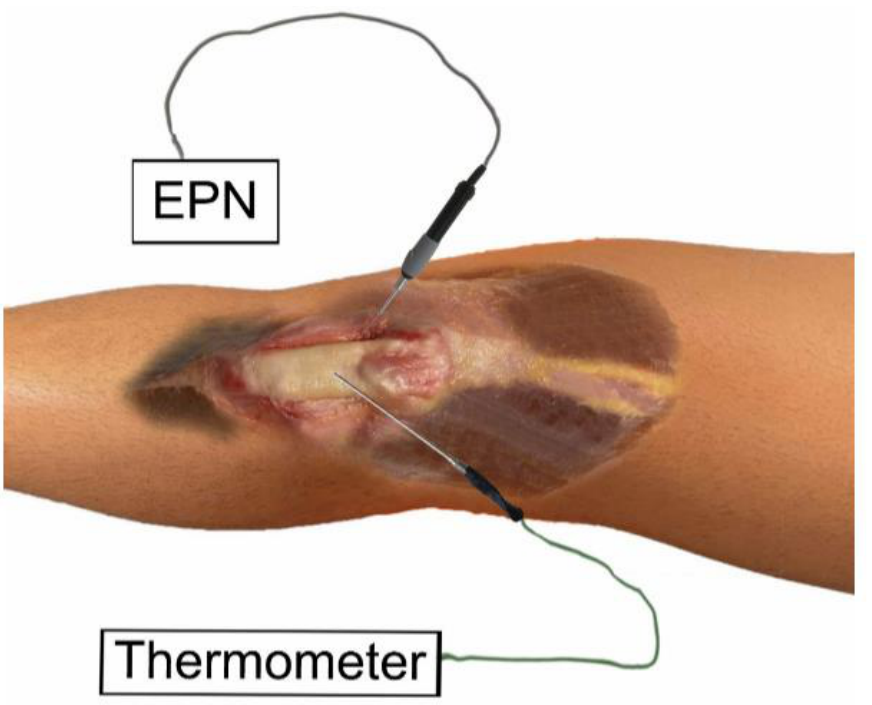
Figure 2. Application of percutaneous needle electrolysis on the patellar tendon on an anatomic sample.